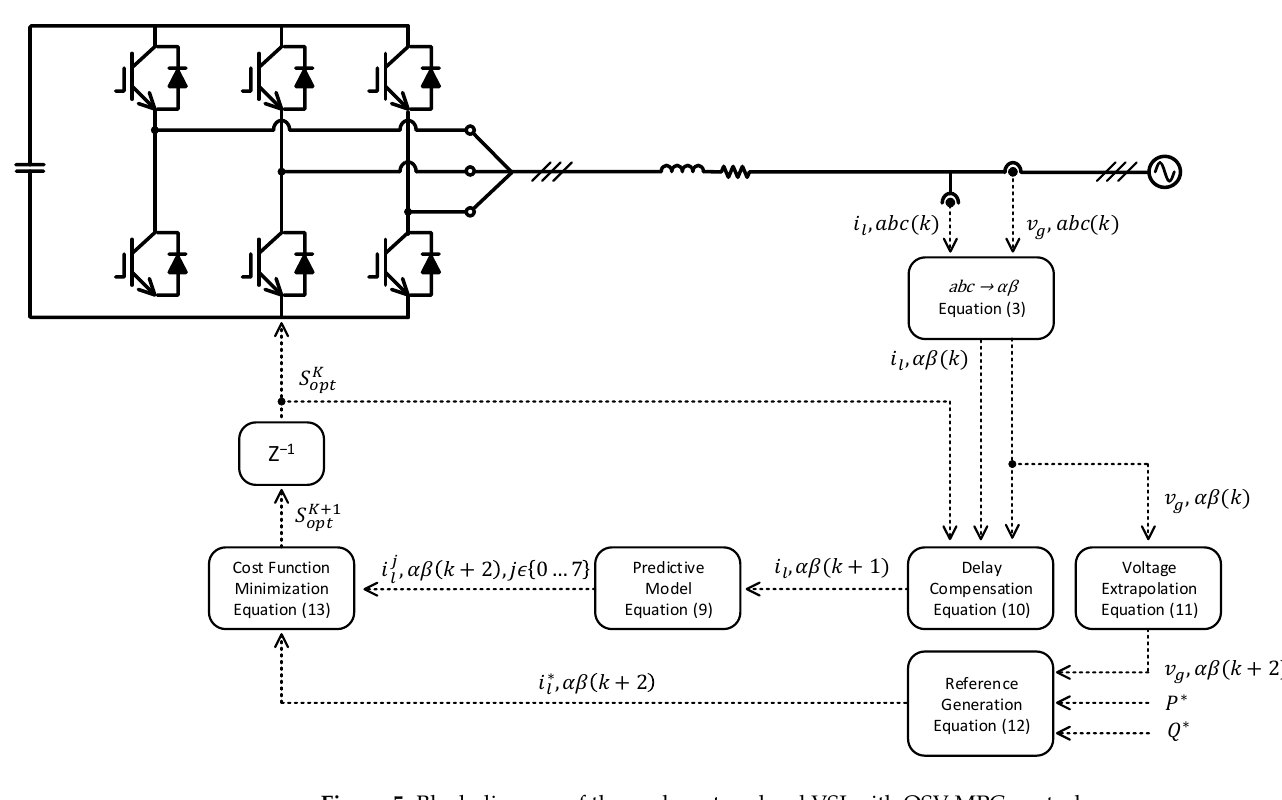
Figure 5. Block diagram of three-phase two-level VSI with OSV-MPC control.